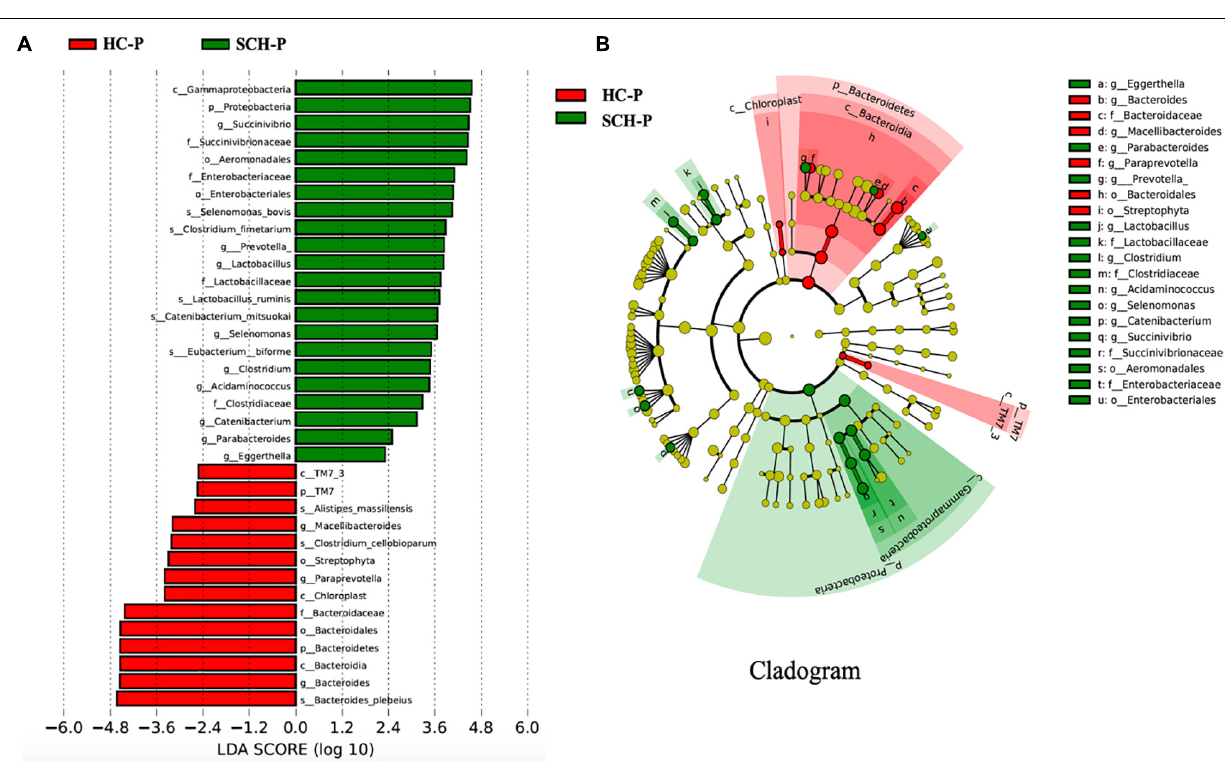
Frontiers in Psychiatry |